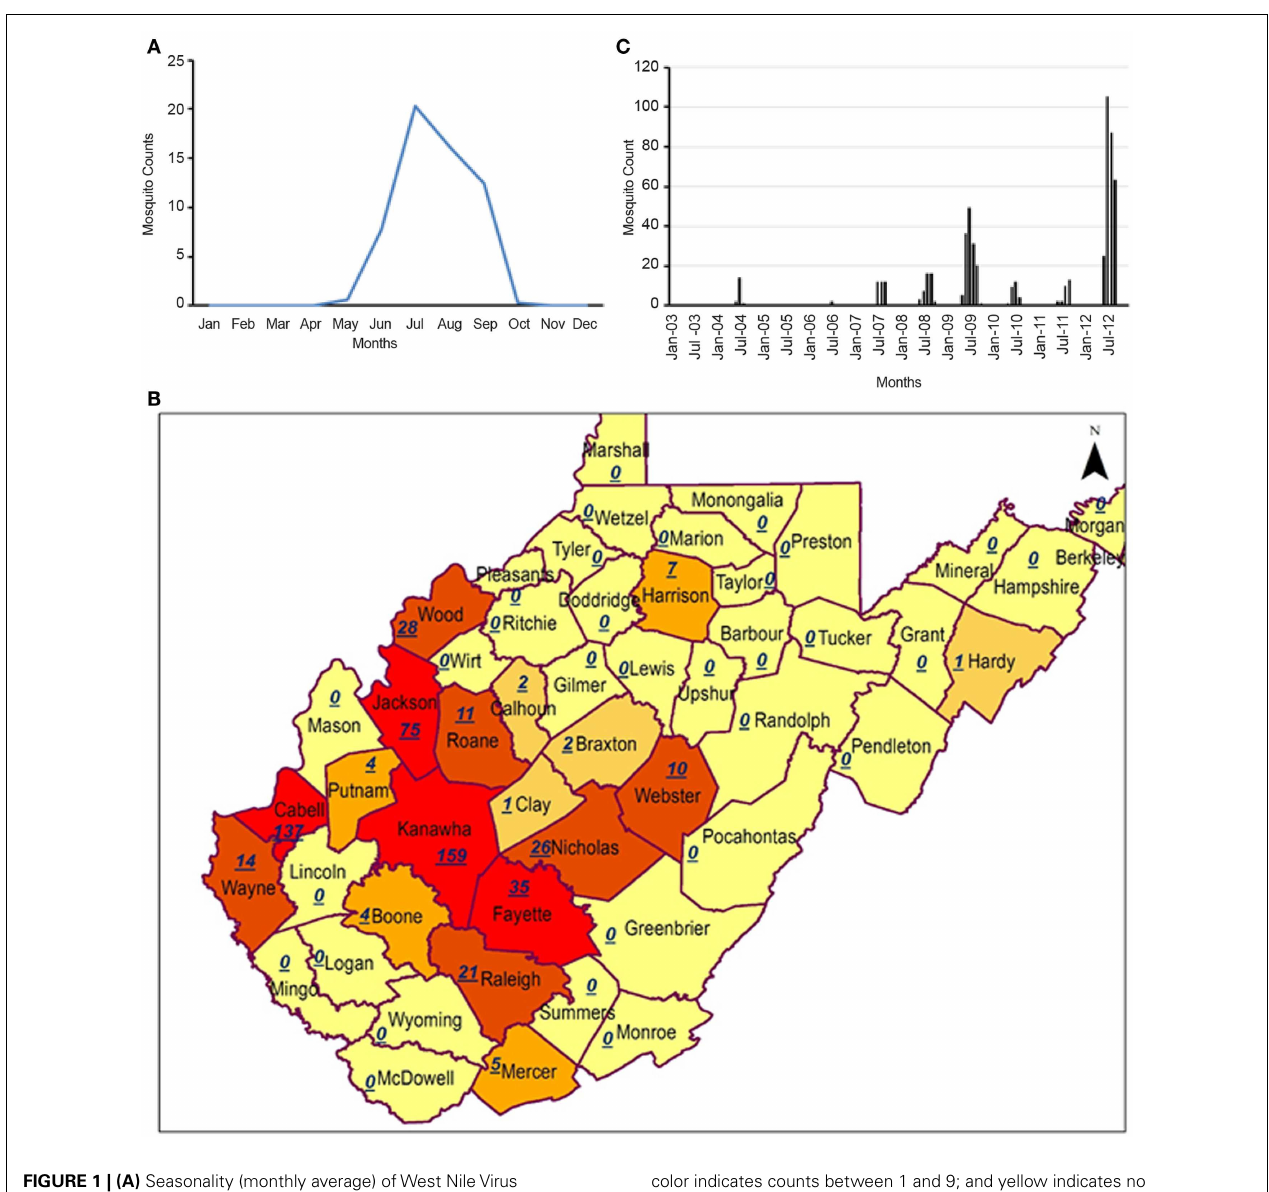
FIGURE 1 | (A) Seasonality (monthly average) ofWest NileVirus positive mosquitoes from 2003 to 2012; (B) cumulative spatial distribution of positive infectious mosquitoes from 2003 to 2012 [red color indicate positiveWNV mosquito counts > 9; orange